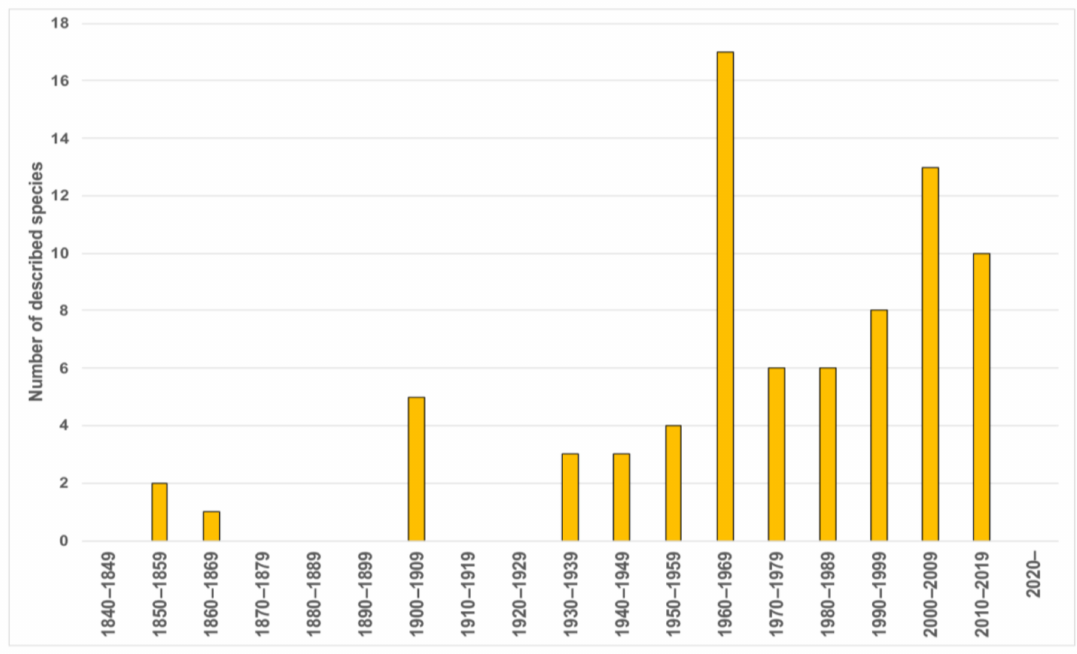
Figure 4. Number of magelonid species described per